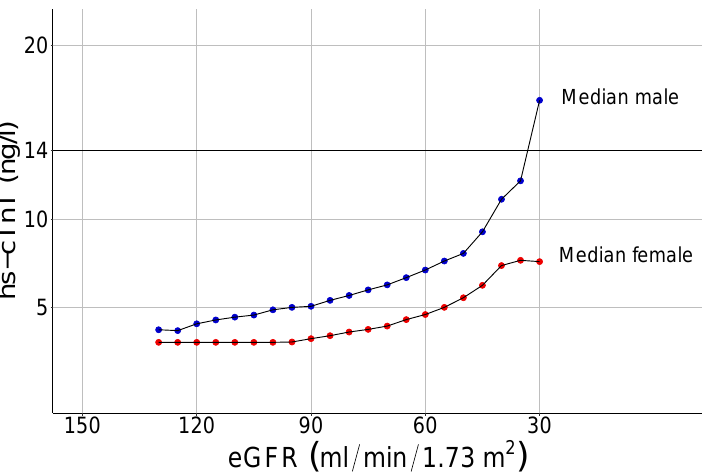
Figure 4. Floating median hs-cTnT values in relation to eGFR (window size of +/ − 10 mL/min/ 1.73 m 2 per point, steps of 3 mL/min/1.73 m 2 ) in females (red curve) and males (blue curve). There is a negative correlation between eGFR and hs-cTnT concentrations. Hs-cTnT: highly sensitive troponin T; eGFR: estimated glomerular filtration